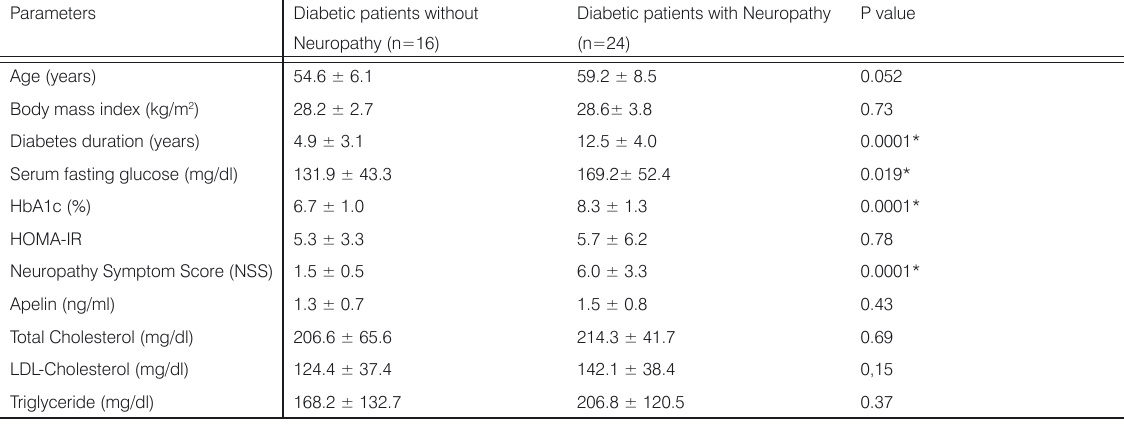
Table 2. Comparison of parameters in diabetic patients with and without neuropathy.